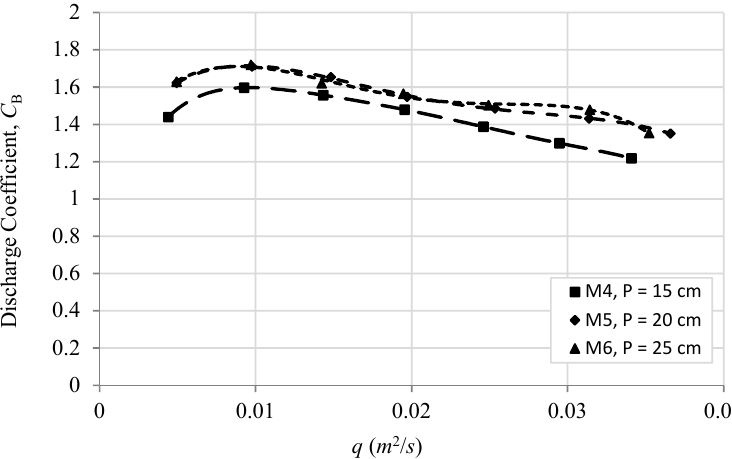
Figure 15. Discharge coefficient, C B , vs. unit discharge, q, for models M4, M5, and M6.